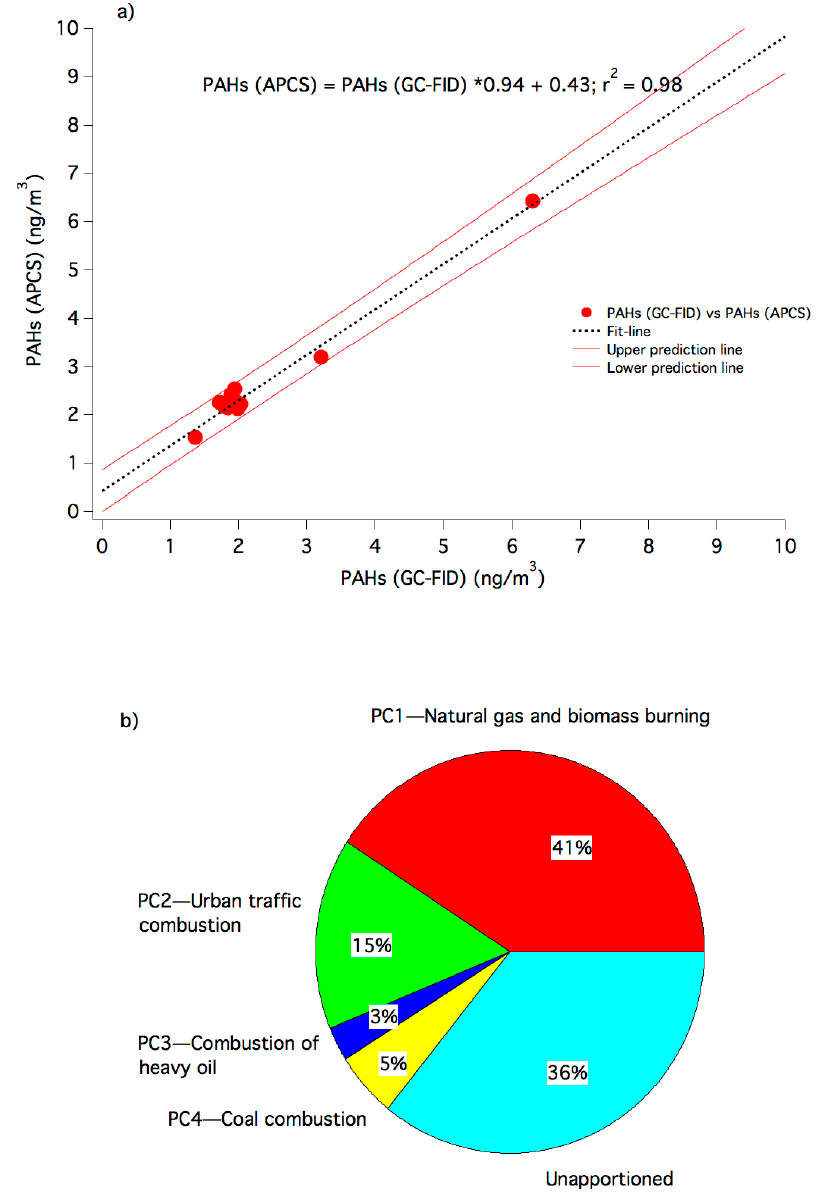
Figure 4. ( a ) A correlation plot of estimated PAHs by APCS and measured PAHs using GC-FID and ( b ) the percentage of predicted PAH sources with the application of PCA-APCS in Kuala